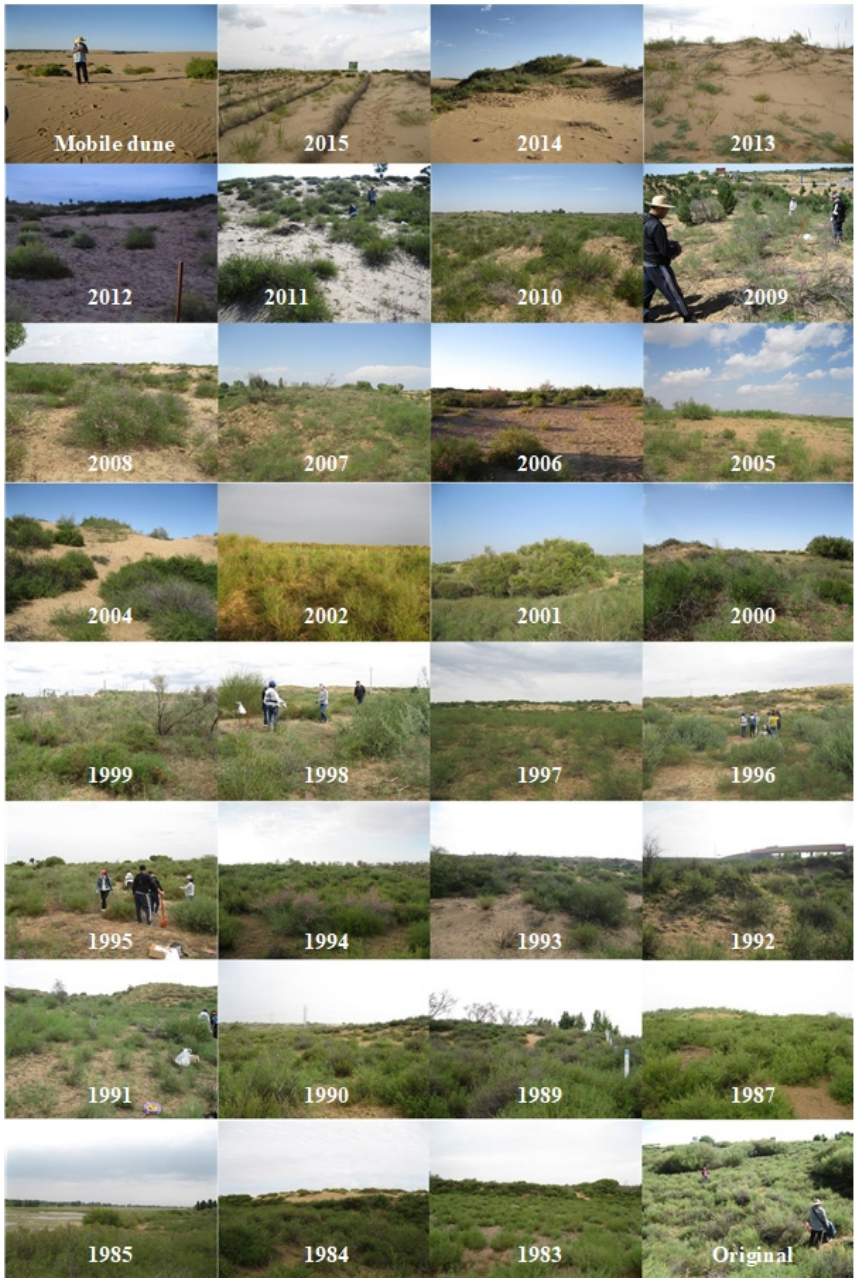
Figure 2. The photographs of 32 investigated field sites from 1983 to